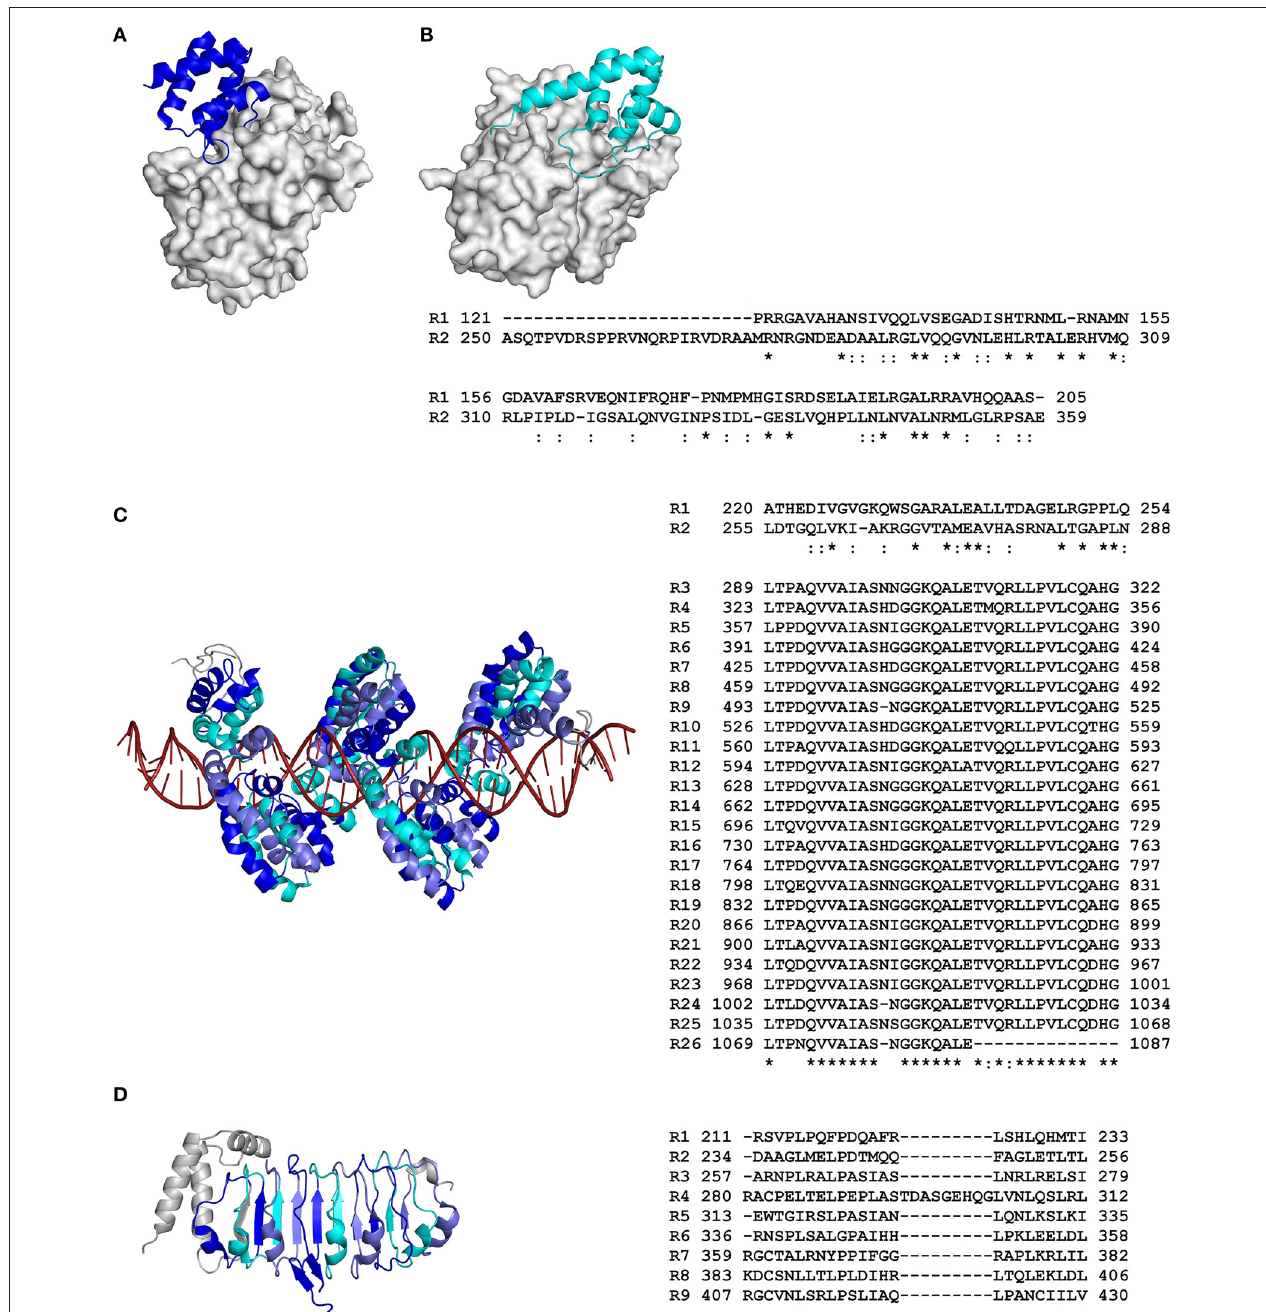
FIGURE 1 | Primary and tertiary structures of repeat domains from RCP effectors of plant-associated bacteria. (A) Crystal structure of repeat unit one from the AvrPtoB effector of the tomato bacterial speck pathogen, Pseudomonas syringae pv. tomato ( Pst ), in complex with the tomato Pto kinase (Protein Data Bank [PDB] code 3HGK; Dong et al., 2009). (B) Nuclear magnetic resonance (NMR) structure of repeat unit two from AvrPtoB of Pst in complex with the BAK1 kinase domain from Arabidopsis thaliana (3TL8; Cheng et al., 2011). Note that in (A) , AvrPtoB repeat unit one interacts with the Pto kinase in a different orientation to that of AvrPtoB repeat unit two with the BAK1 kinase domain in (B) . (C) Crystal structure of the repeat domain from the PthXo1 transcription activator-like (TAL) effector of the bacterial rice pathogen, Xanthomonas oryzae pv. oryzae , bound to its natural DNA target (36 bp). The repeats pack together to form a left-handed superhelix ( α -solenoid) that wraps around the DNA molecule (3UGM; Mak et al., 2012). (D) Crystal structure of the N-terminal leucine-rich repeat (LRR) domain from the XopL effector of the bacterial leaf spot pathogen of pepper and tomato, Xanthomonas euvesicatoria (4FCG; Singer et al., 2013). Structural coordinate files were downloaded from the Research Collaboratory for Structural Bioinformatics (RCSB) PDB (http://www.rcsb.org/pdb/home/home.do). Alternating repeat units are colored blue, slate, and cyan, respectively. Non-repetitive sequence is colored gray. The molecular surface of Pto kinase in (A) and BAK1 kinase domain in (B)